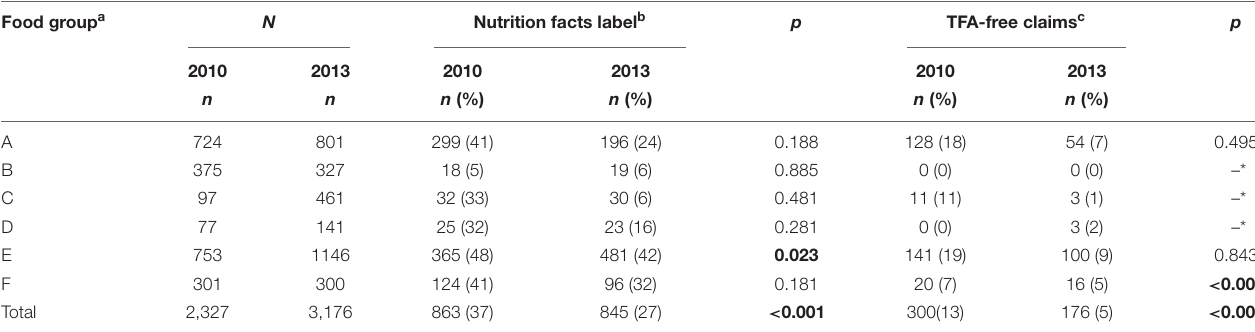
TABLE 5 | Prevalence of false-negative information on trans-fat acids (TFA) in packaged foods sold in Brazil in 2010 and 2013, as identified by comparison of the nutrition facts label and TFA-free claims with the ingredients list. Food group a N Nutrition facts label